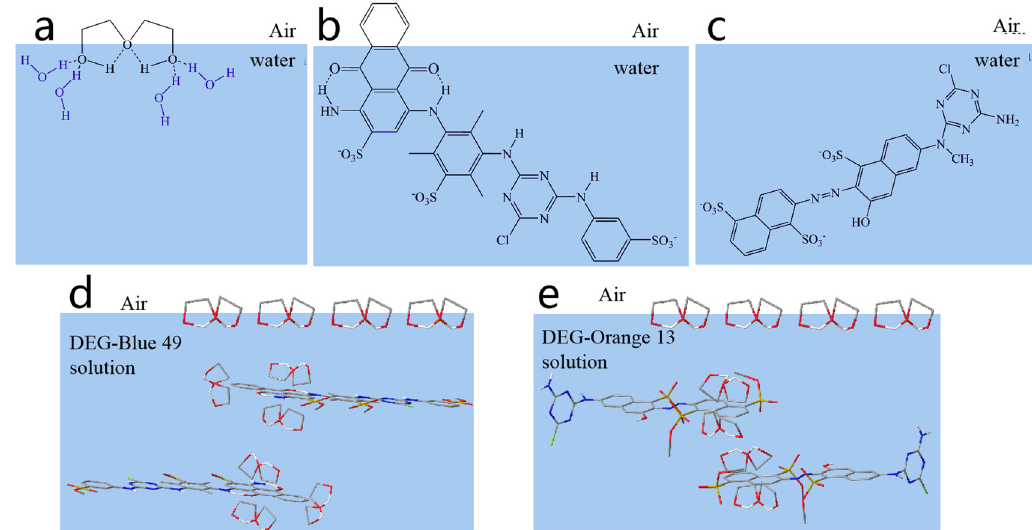
Figure 5. Arrangement of ( a ) DEG molecule, ( b ) Reactive Blue 49 molecule, and ( c ) Reactive Orange 13 molecule at air/water interface. ( d , e ) Arrangement of molecules at air/DEG –dye solution interface, ( d ) Reactive Blue 49-DEG solution, ( e ) Reactive Orange 13-DEG solution.